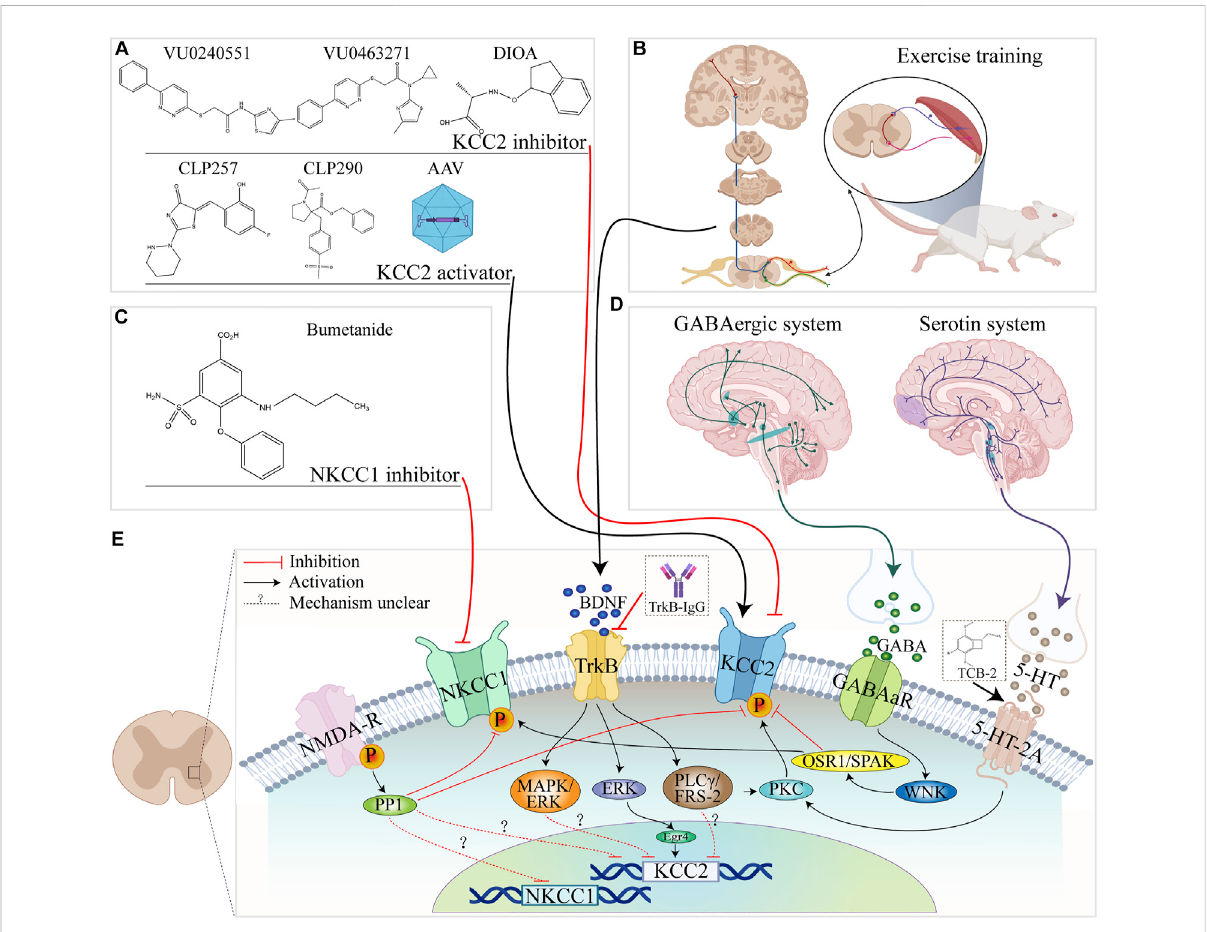
Summary of NKCC1 and KCC2 regulatory pathways in the spinal cord and related pathways. (A) The molecular formulae of commonly used KCC2 activators and inhibitors. (B) Exercise training. (C) Molecular formula of the NKCC1 inhibitor bumetanide. (D) Brain origin of 5-HT and GABAergic systems. (E) Schematic diagram of the relationship between KCC2/NKCC1 and upstream factors, channels, and pathways in spinal